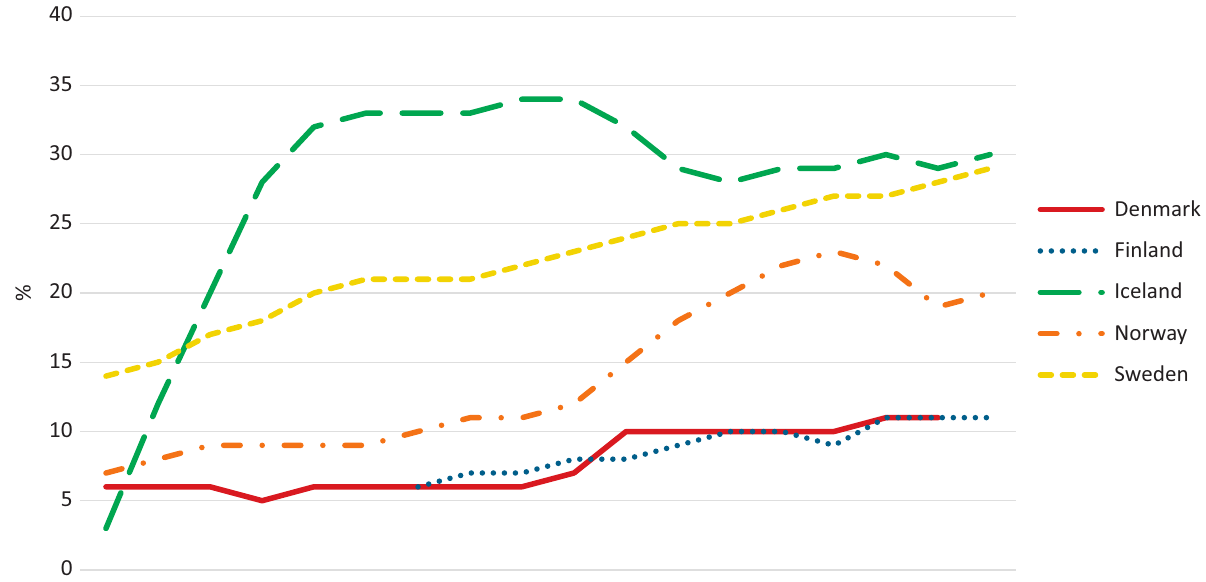
Figure 5. Fathers’ parental leave take-up (share of total parental leave days; Nordic countries, 2000‒2017). Source: NOSOSCO